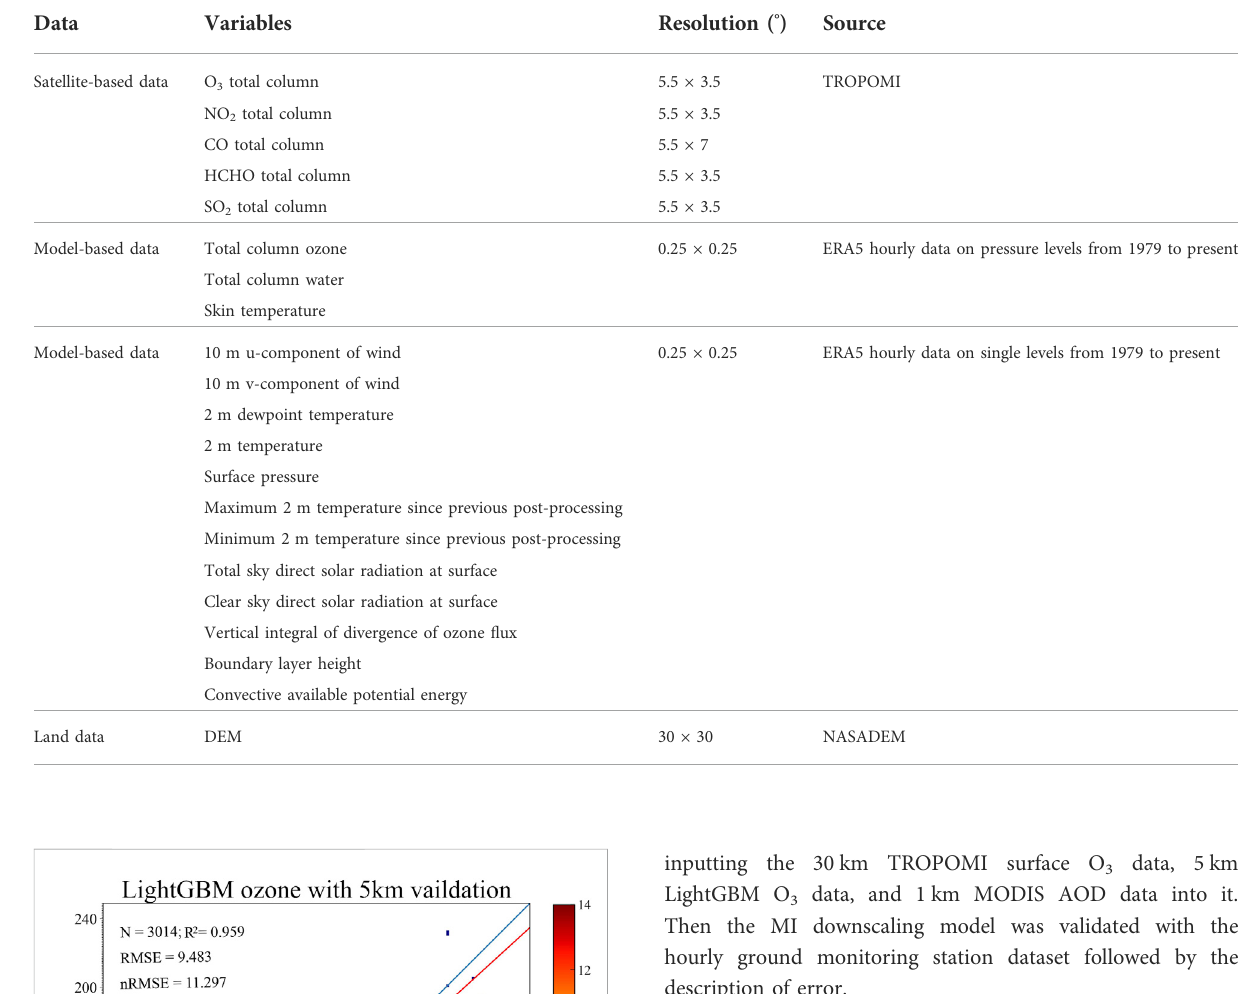
TABLE 2 Independent variables of the LightGBM model.